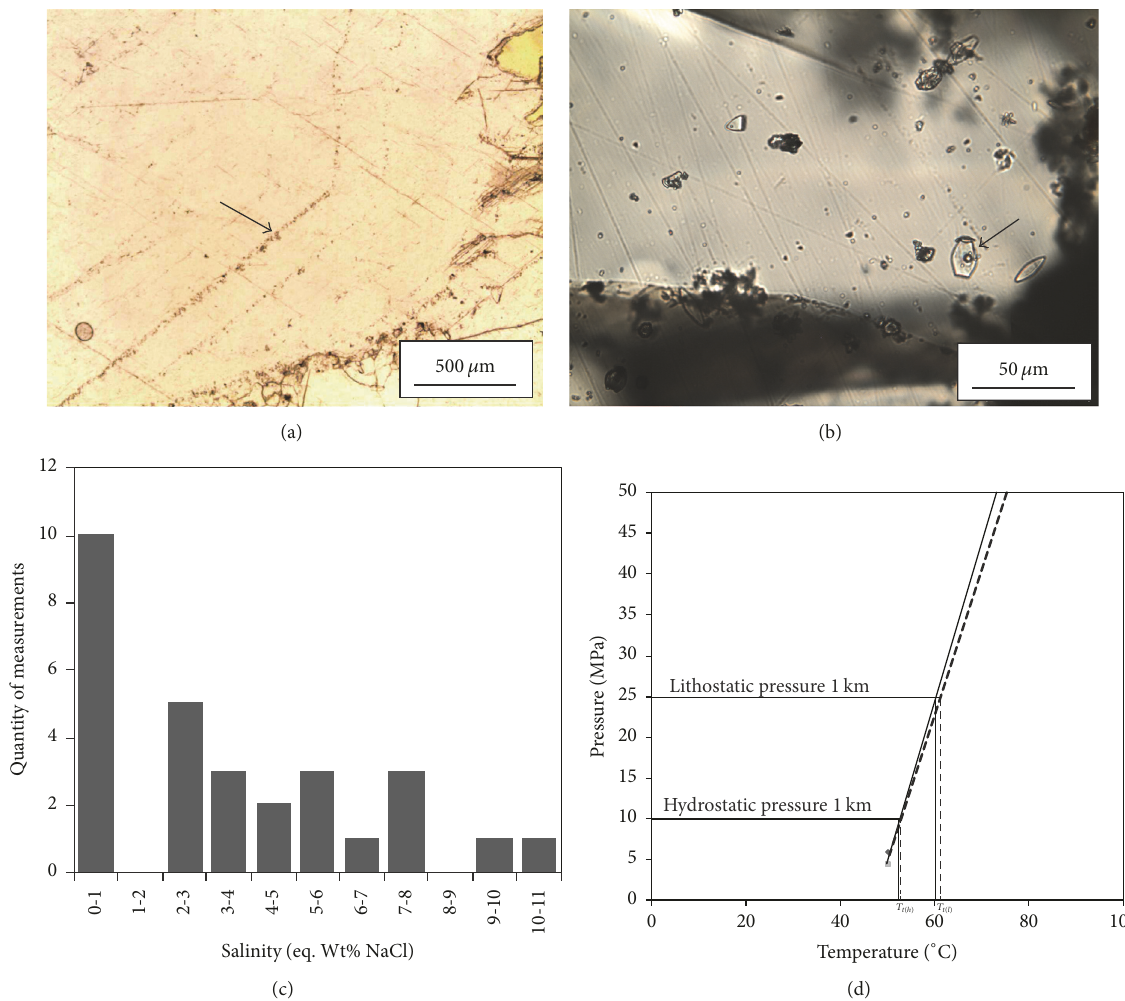
Figure 6: Synthesis of the fluid inclusions data. (a) Optical microscopy observation of inclusions arranged along crystal growth planes (arrow). (b) Zoom-in on a two-phase aqueous inclusion (arrow). (c) Distribution of the salinity values calculated from microthermometry. (d) Pressure-temperature diagrams and isochores of a low salinity system (full line) and an intermediate salinity system (dashed line) and estimated trapping temperature ( 𝑇 𝑡 ) assuming a 1km hydrostatic or lithostatic